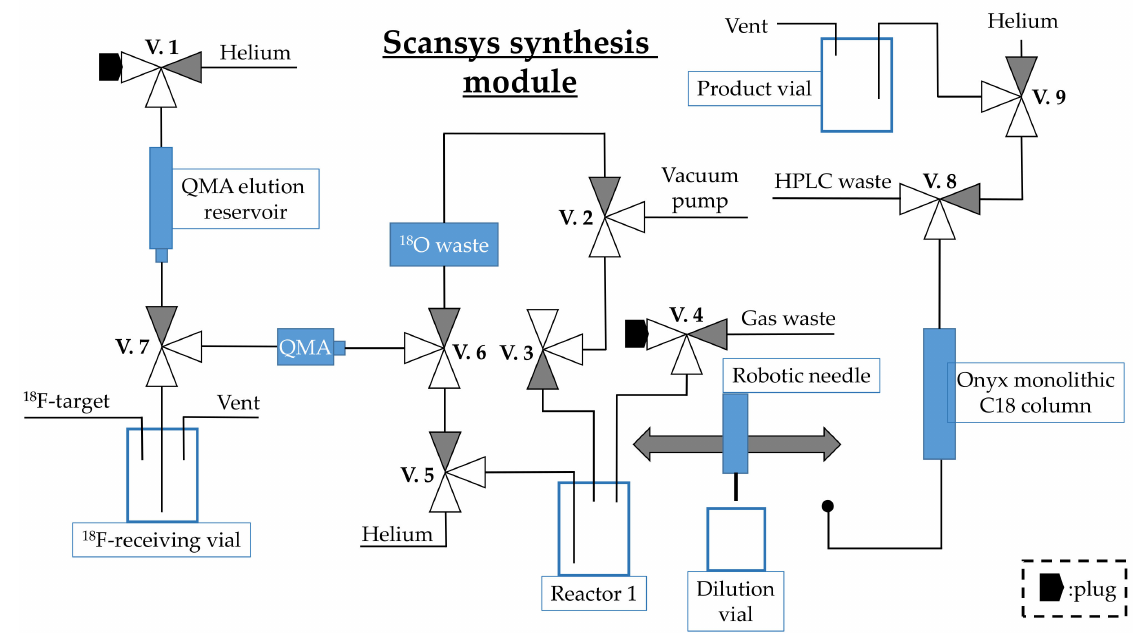
Figure 9. Setup of the Scansys synthesis module used for synthesis of [ 18 F]FE-PE2I.